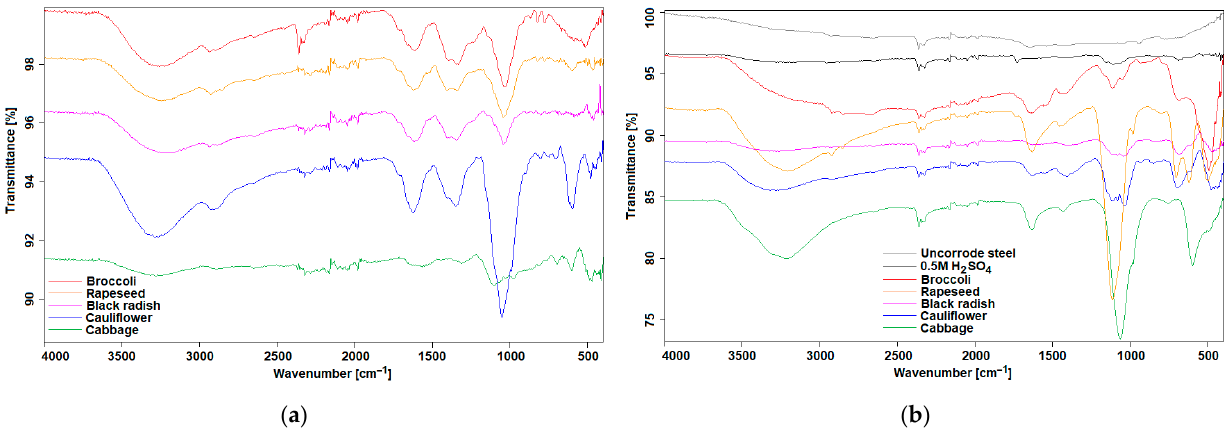
Figure 7. FT-IR analysis: ( a ) Brassicaceae extracts; ( b ) Steel surface after 24 h of exposure to a solution of 0.5 M H 2 SO 4 , with and without Brassicaceae extracts, at 20 °C. Table 7. The changes in the FT-IR spectra of inhibitor fi lm compared to Brassicaceae extracts.